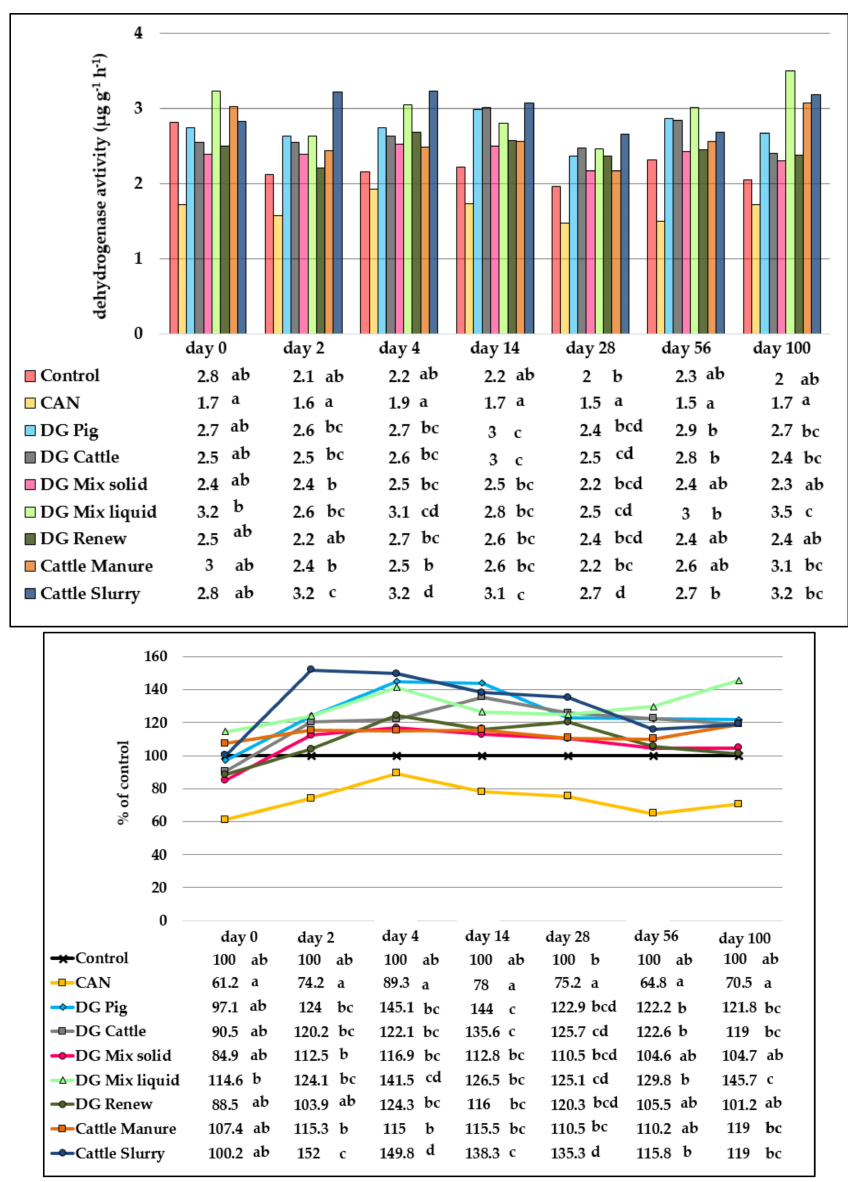
Figure 3. Dehydrogenase activity (DHA) in the field experiment. Bars show absolute values; lines show the percentage of DHA in comparison to the control (control = 100%). Di ff erent letters mark significant di ff erences between treatments within one column, viz. on the respective day of measurement (Tukey’s HSD test, p ≤ 0.05, n =